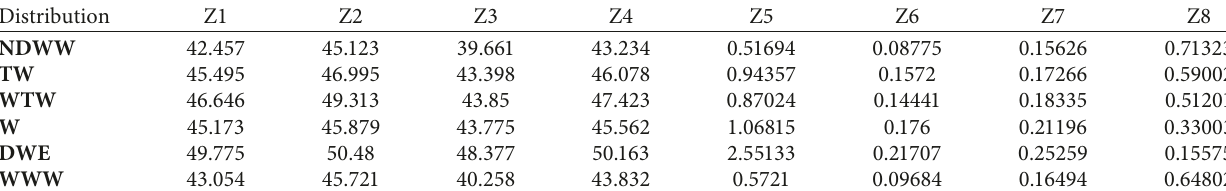
Table 9: Numerical values of Z1, Z2, Z3, Z4, Z5, Z6, Z7, and Z8 for the dataset (2).